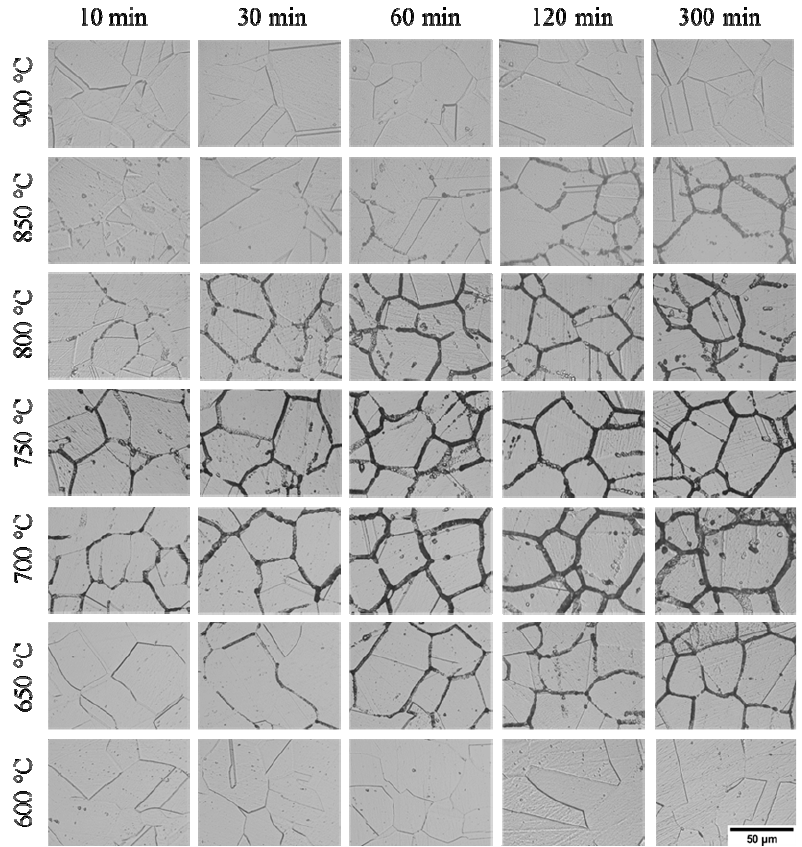
Figure 9. Optical micrographs of the Cr–Mn–Ni–N–Cu austenitic stainless steel samples aged under different heat treatment conditions after the 10% oxalic acid etch.